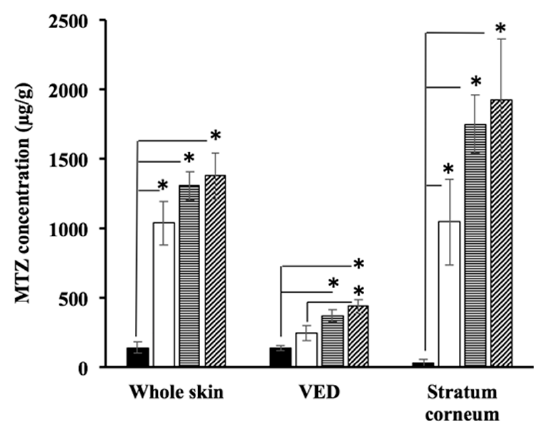
Figure 5. MTZ concentrations in the skin as a whole, the viable epidermis and dermis (VED), and the stratum corneum after the topical application of Pal-GH gel formulations on hairless rat skin. Significant differences were observed between F5 MTZ , F5 PG-MTZ , F5 IPM-MTZ , and 1% solution of MTZ in the whole skin, and stratum corneum (* p < 0.05). Additionally, significant differences were observed between F5 PG-MTZ and F5 IPM-MTZ with a 1% solution of MTZ and between F5 IPM-MTZ with F5 MTZ in the VED (* p < 0.05). The MTZ concentration of the stratum corneum was estimated by dividing the MTZ difference (between the VED and whole skin) by the weight of the stratum corneum. Closed columns: 1% MTZ solution, open columns: F5 MTZ , horizontal striped columns: F5 PG-MTZ , striped columns: F5 IPM-MTZ .